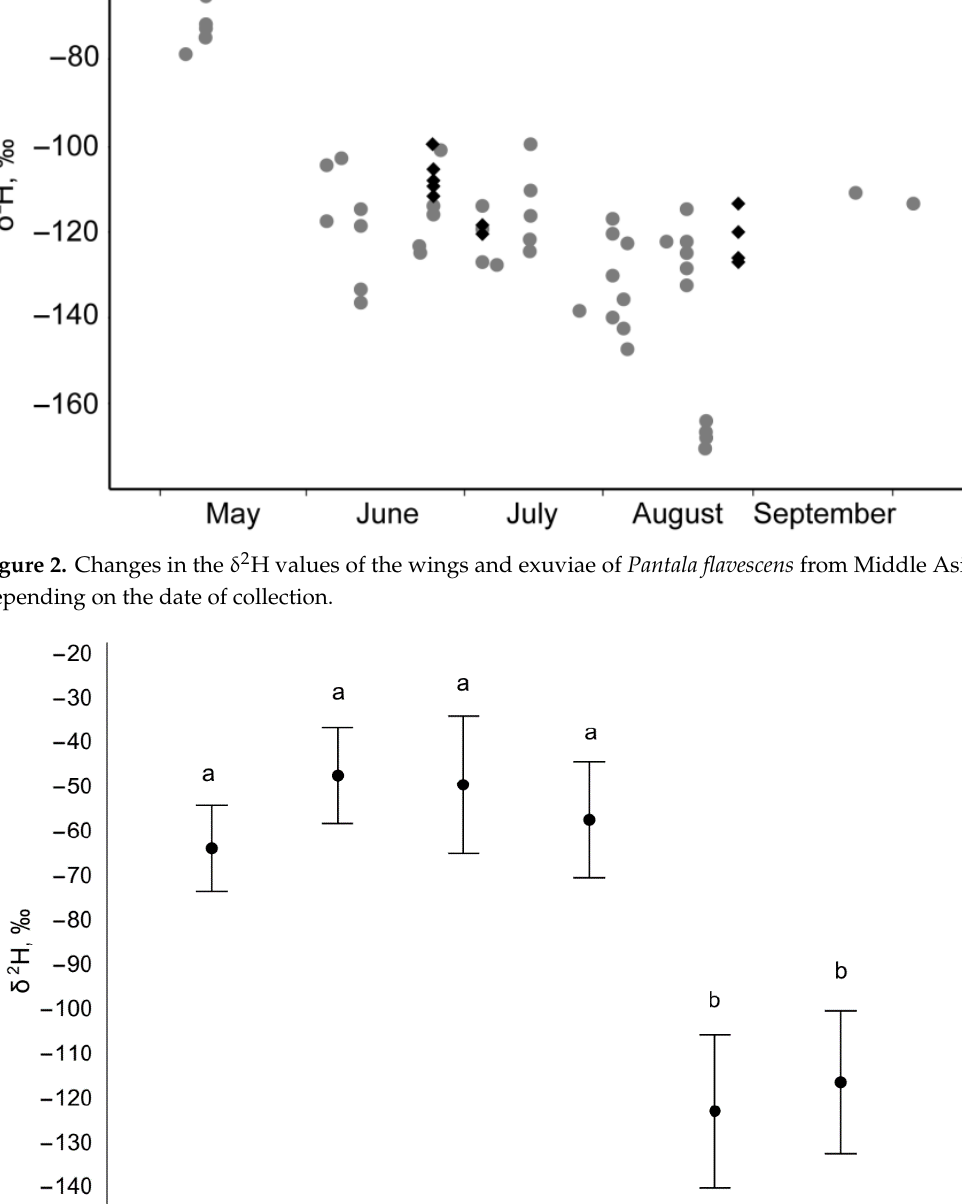
Figure 2. Changes in the δ 2 H values of the wings and exuviae of Pantala flavescens from Middle Asia depending on the date of collection.